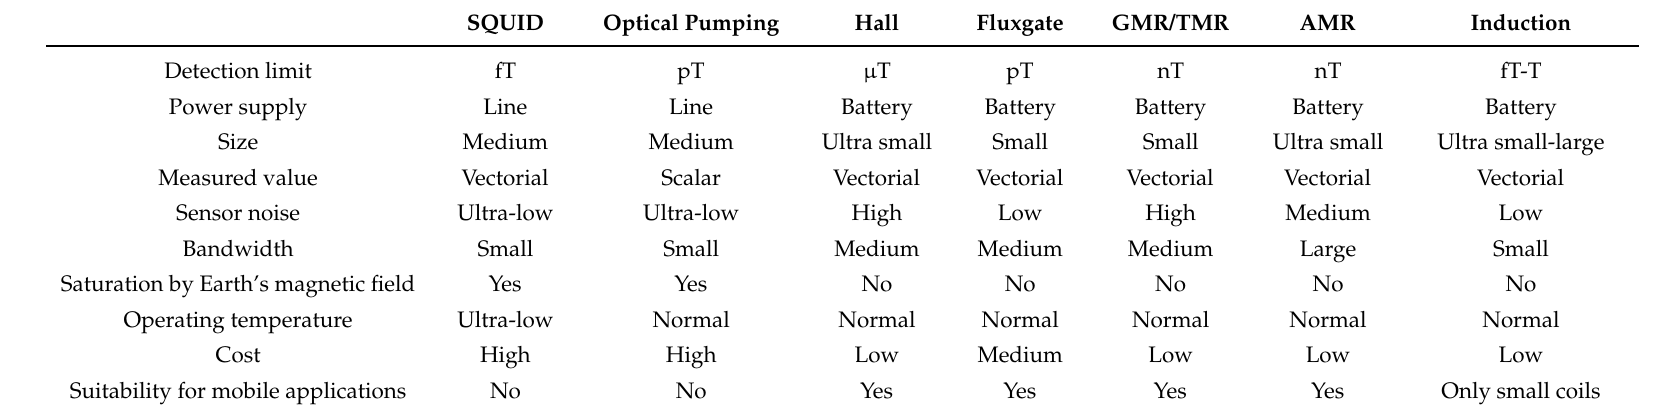
Table 1. Comparison of magnetic sensors regarding mobile communication